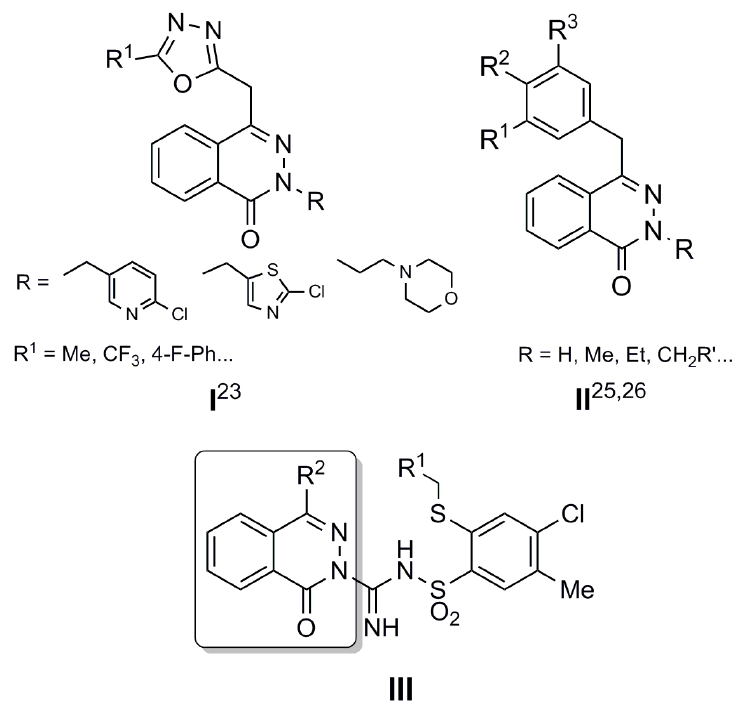
Figure 1. Phthalazine derivatives with antifungal activity [25,27–